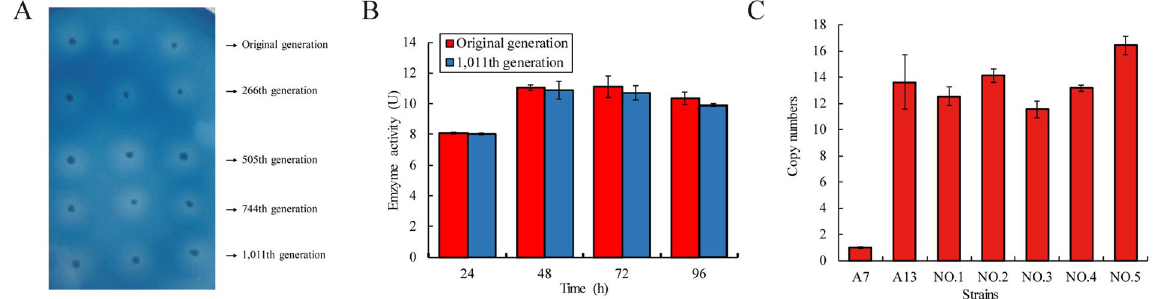
Figure 3. Genetic stability of the S. cerevisiae A13 transformant. ( A ) Cells from the indicated generations of the transformant were cultured on SC -Ura selection plate containing RBB-xylan and galactose. The plates were photographed after incubation at 28 °C for 12 h. ( B ) The xylanase activity of the original and 1,011 th generation A13 strain were measured during fermentation. YPD enrichment and induction medium were used for this experiment. ( C ) The copy number of xynHB in the the genome of 1,011 th generation of A13 strain. No.1 to No.5 represent for the random colonies of 1,011 th generation of A13 strain. Figure 3C indicated that the copy number of A13 strain is stable even after 1,011 th generation of subculture.